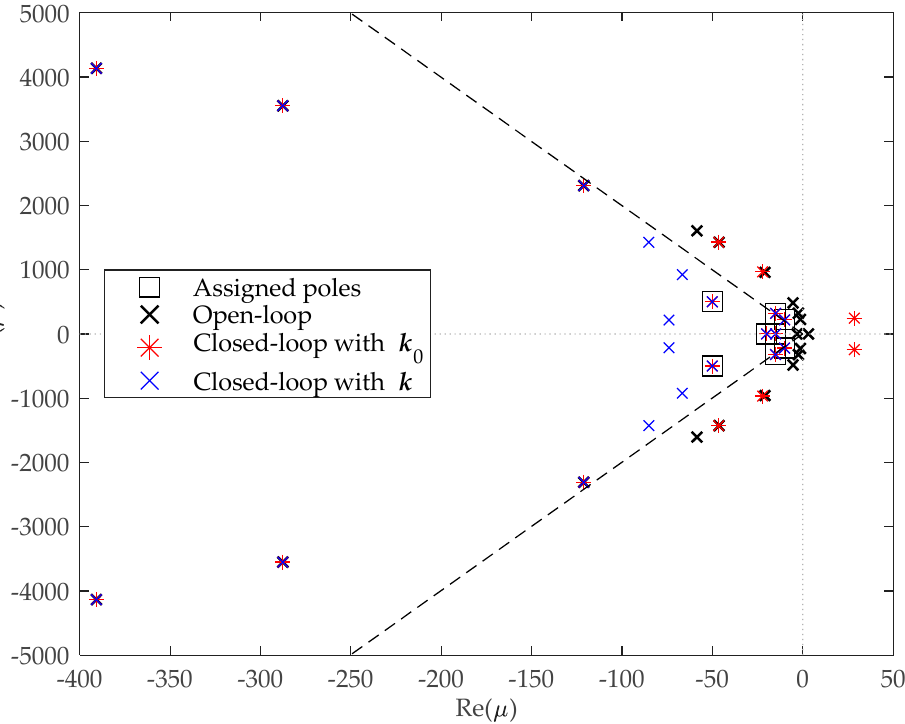
Figure 12. Pole map of the four-bar linkage: low frequency detail (test-case 4).